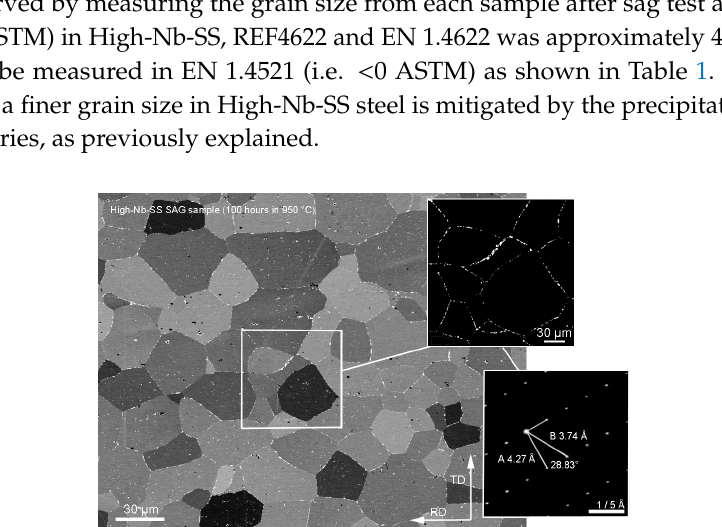
microstructure of a sag sample after 100 h at 950 °C as expected. The larger grain size of the trial steel